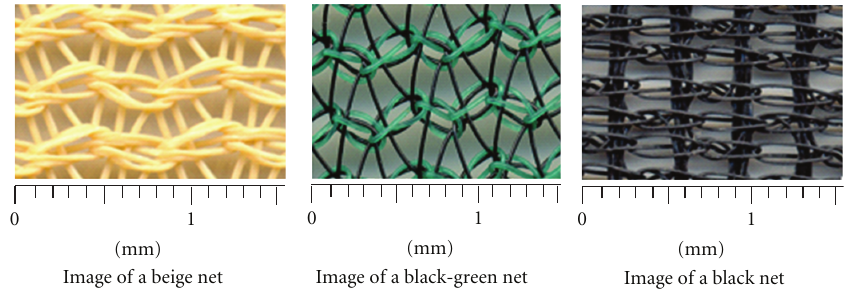
Figure 1: Scanner images of a net in each group tested in this study.